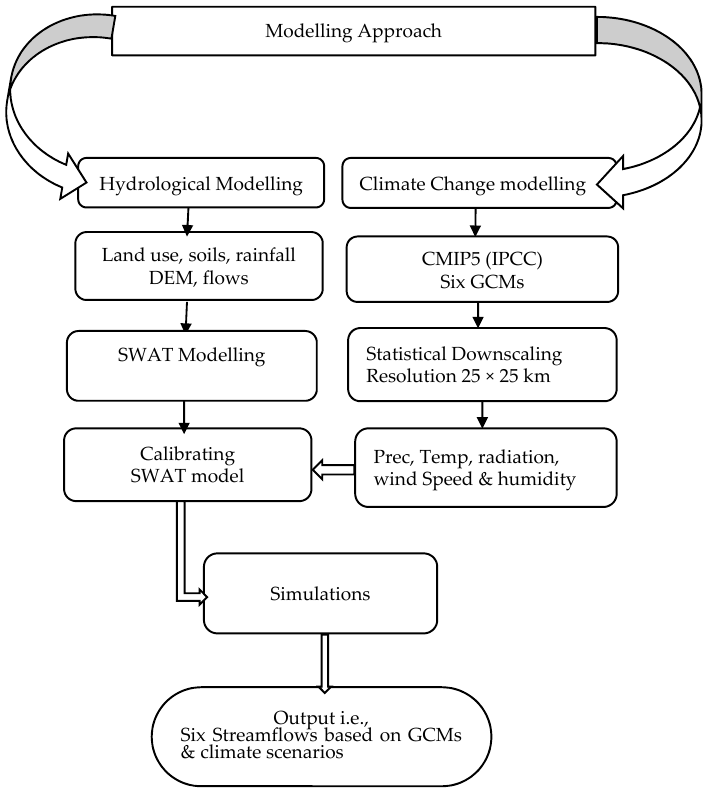
Figure 2. Modelling Approach.